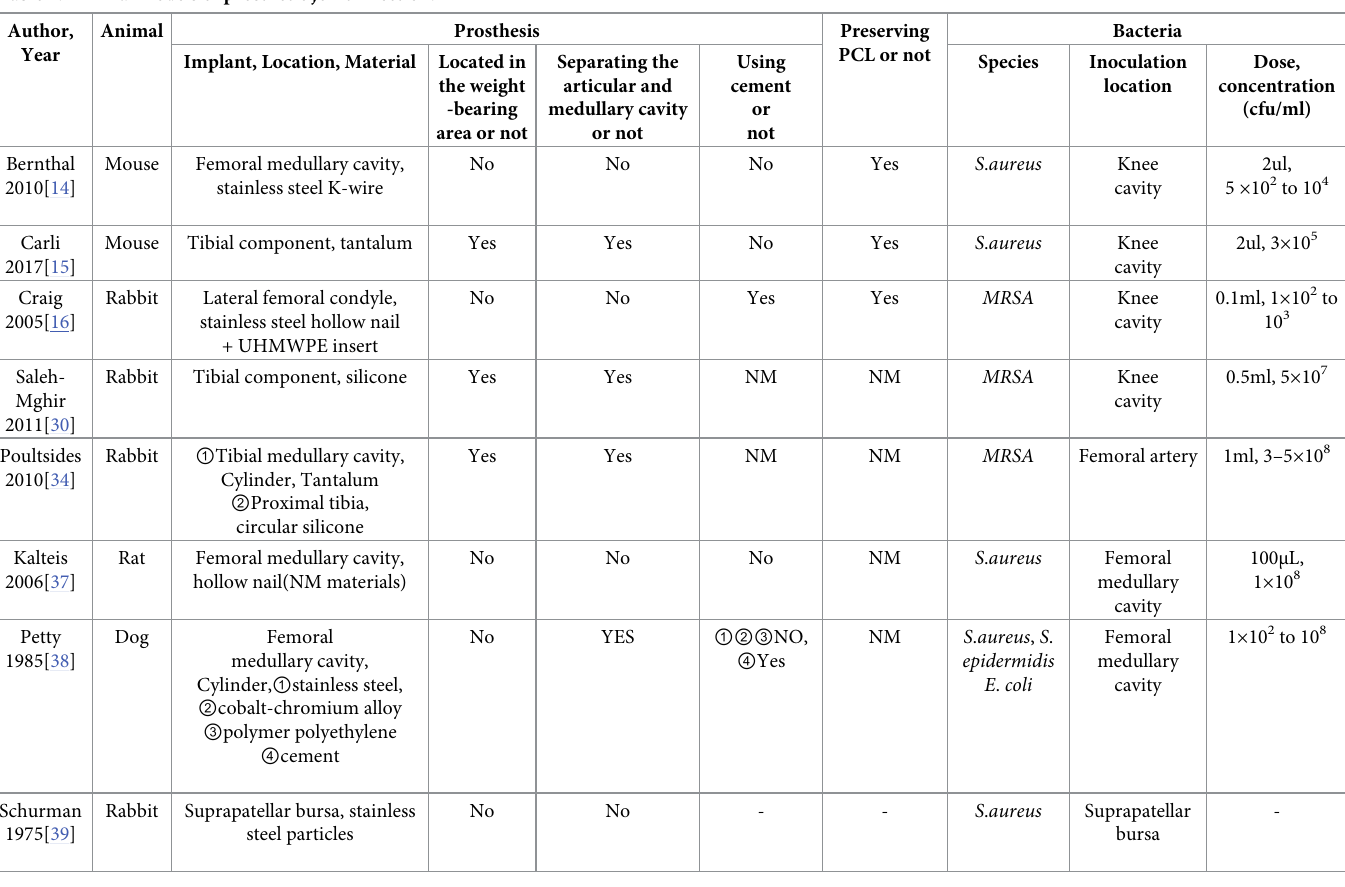
Table 1. Animal models of prosthetic joint